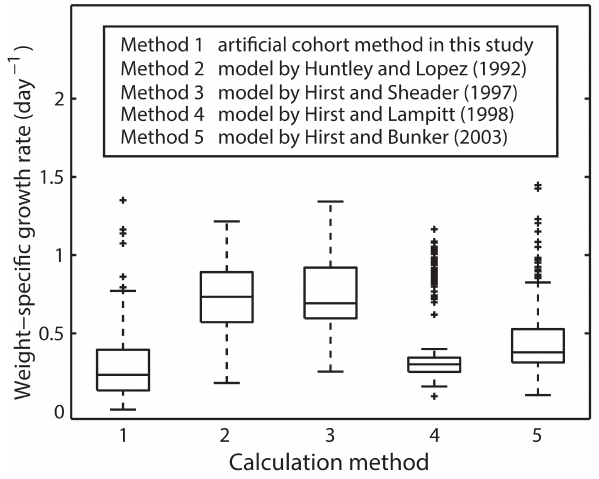
Fig. 8. Measured weight-specific growth rates compared to model- derived growth rates. The boxplots for each taxon indicate the val- ues of medians, 25th and 75th percentiles, 95% confidence intervals (whiskers), and outliers